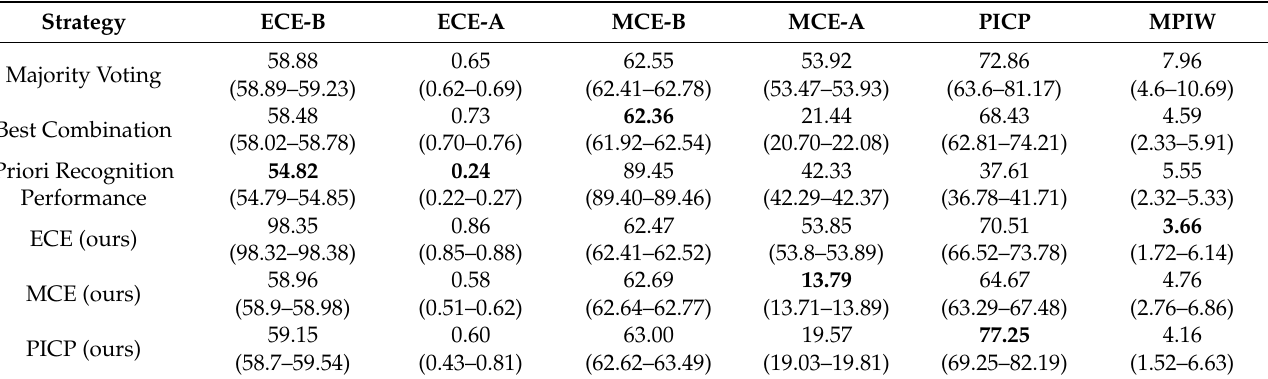
Table 3. Calibration (in %) of the ensembled models on unseen data.